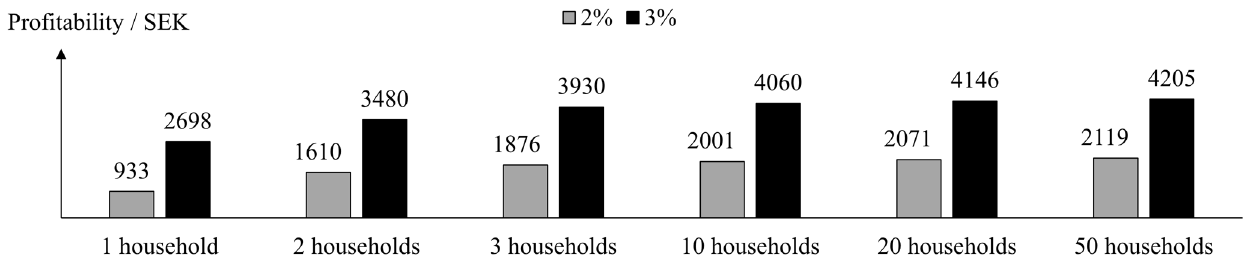
Figure 8. Average household profitability with a 0.25 kWp PV system in Karlstad. Comparison between electricity price growth scenarios of 2% and 3%.